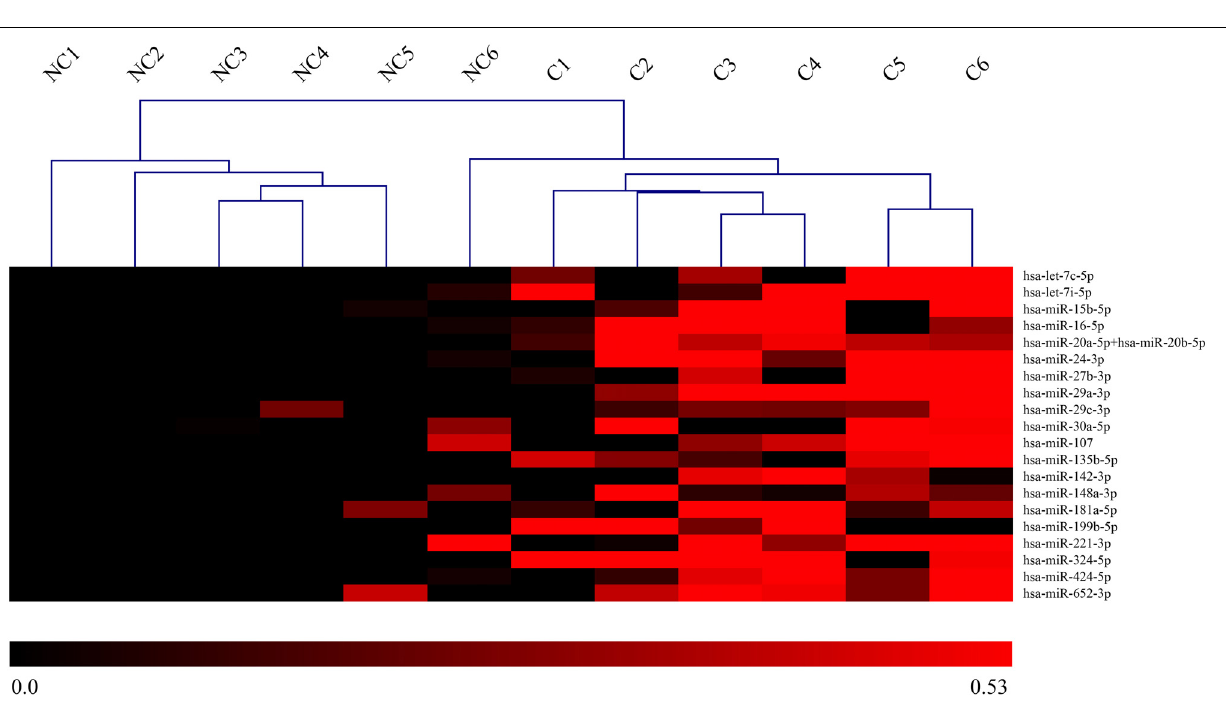
Frontiers in Molecular Neuroscience |